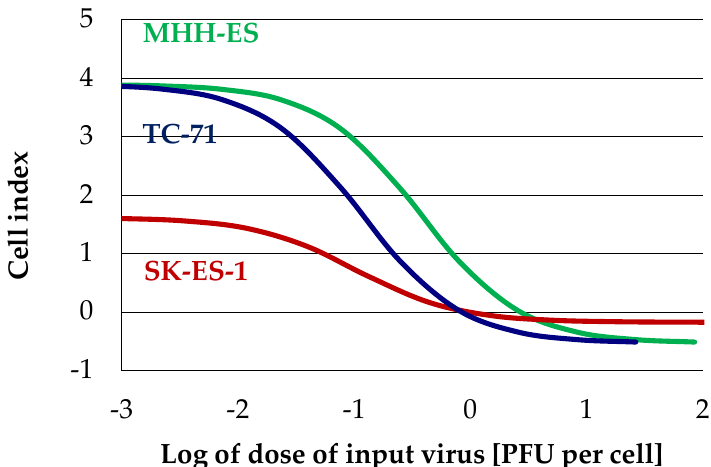
Figure 5. Ewing sarcoma cells undergo lytic H-1PV infection. Dose-response graphs for H-1PV-infected cells, determined by real-time proliferation measurements as described under Materials and Methods. EC50 values were calculated on the basis of these experiments are shown in Table 2. Table 2. ED50 values for Ewing sarcoma cells with fibroblast-like morphology. Cell Line ED50 [PFU/Cell] R 2 Observation Time MHH-ES 0.32